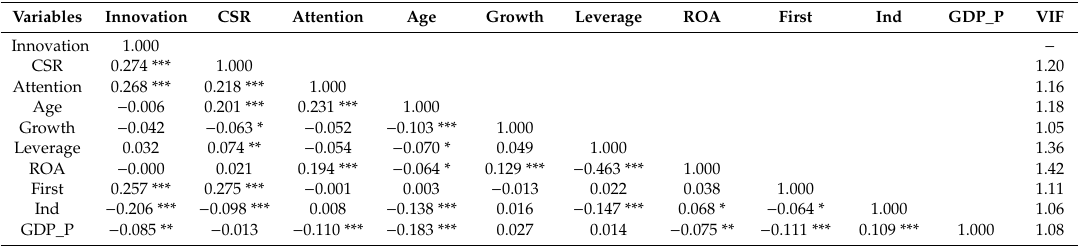
Table 3. Pearson Correlation